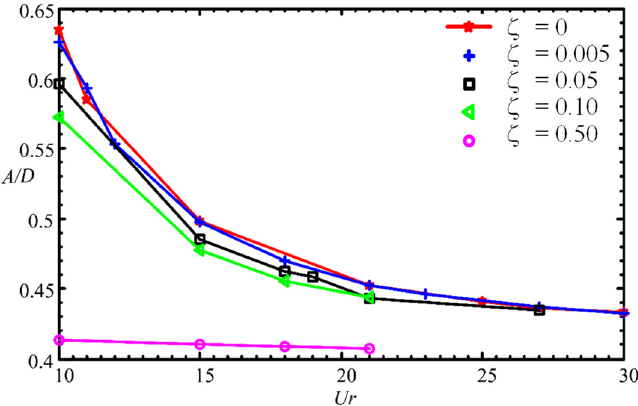
Figure 6. Effect of damping ratio ζ on vibration amplitude A/D . L/D = 3 and m * = 2.